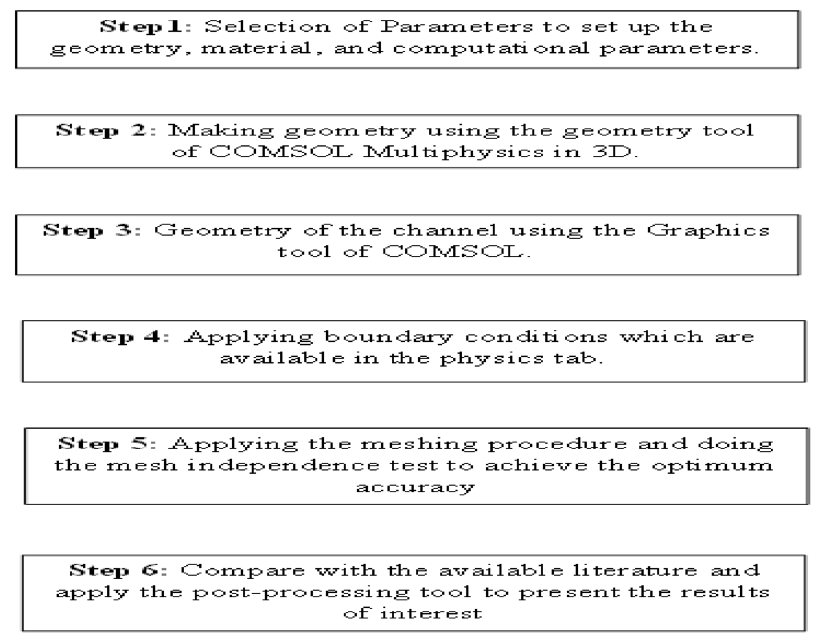
Figure 2. The Working Wagon Wheel of COMSOL.